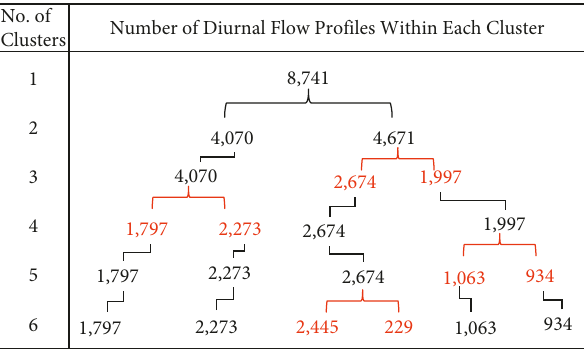
Figure 5: Cluster membership for 1–6